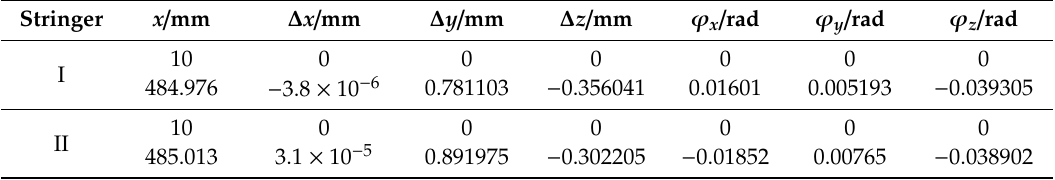
Table 4. Actual boundary conditions prescribed on beam with respect to Cartesian coordinate O b xyz .